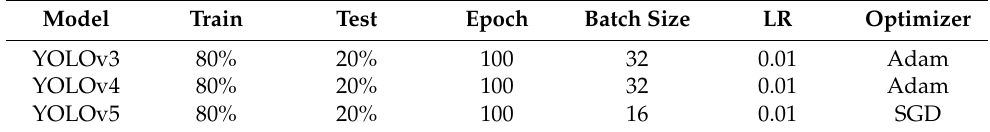
Table 1. Specification of object detection